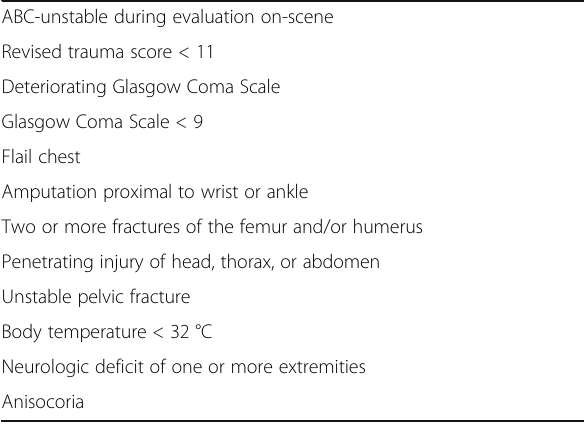
Table 1 Higher-level trauma center criteria of the National Protocol of Ambulance